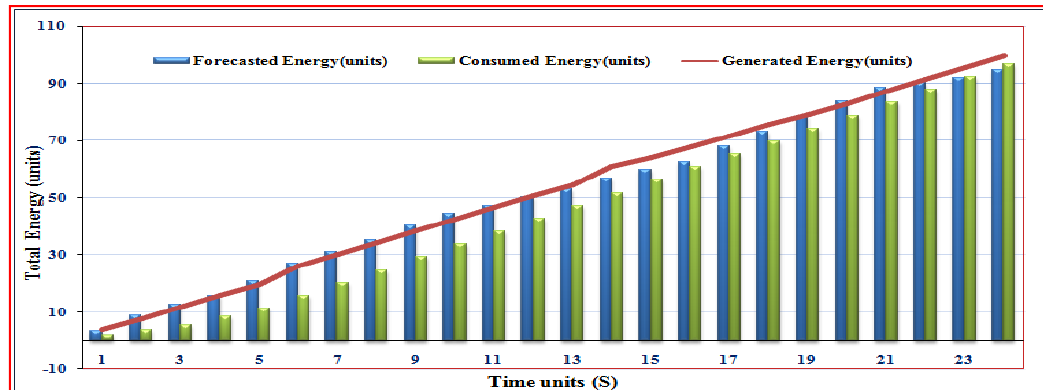
Figure 17. Effective energy management of the controller.